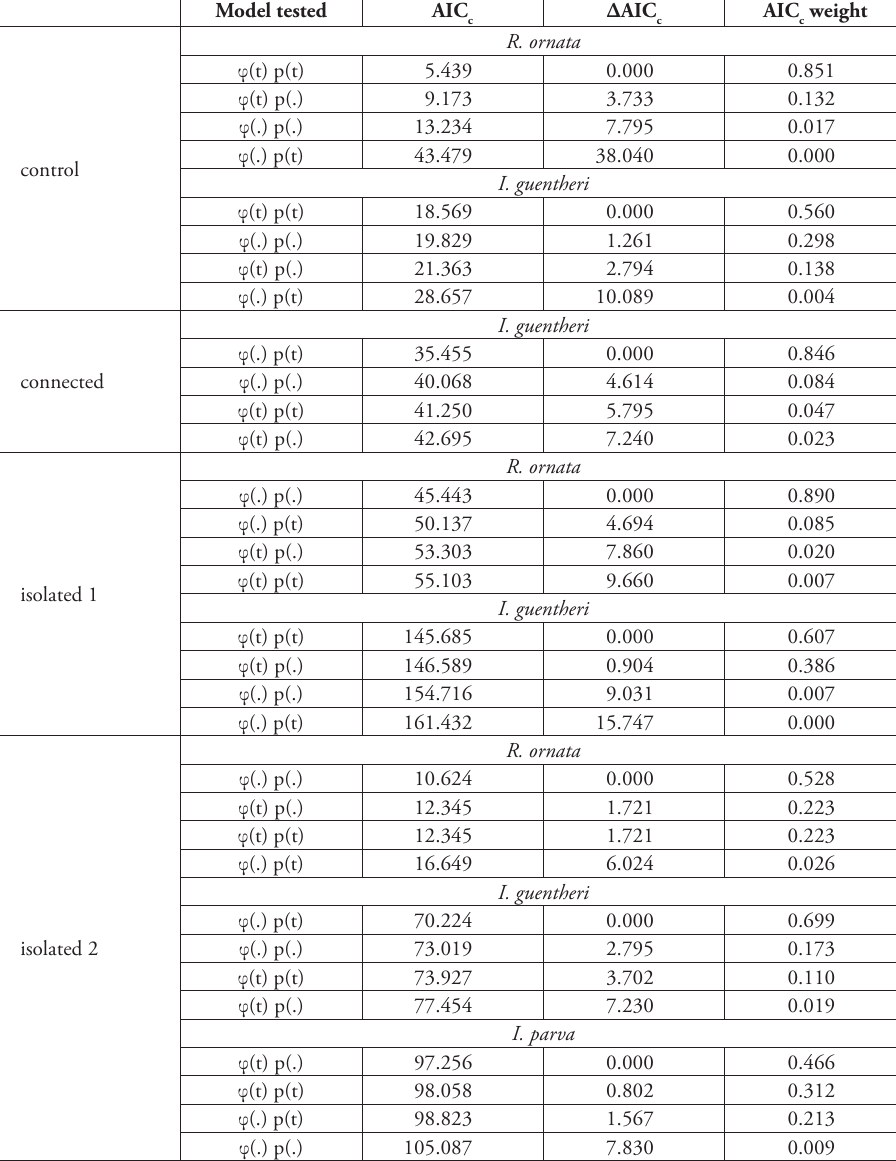
Table 2. Overview of models considered and results of model selection based on the corrected Akaike Information Criterion ( AIC ) for estimating survival probability ( φ C